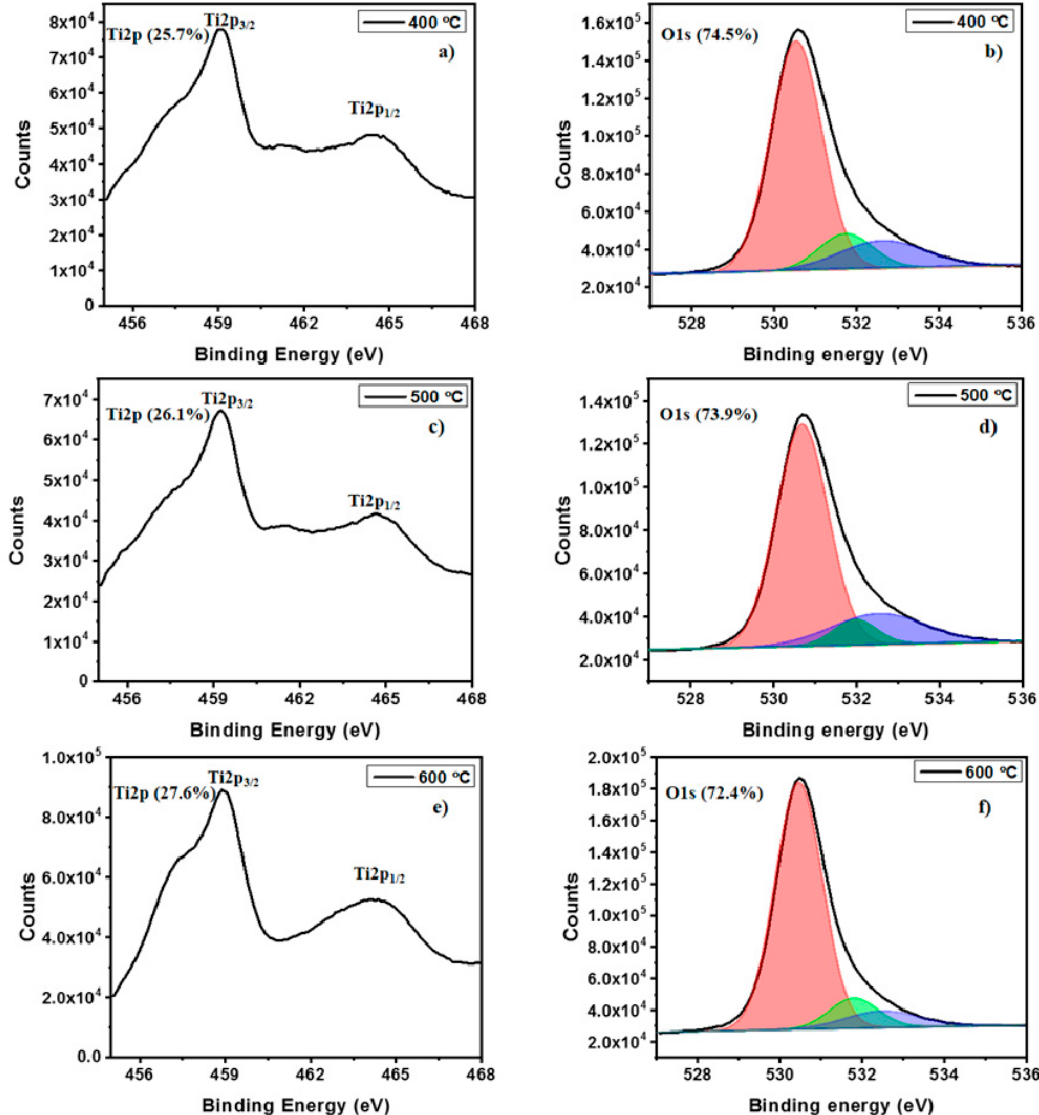
Figure 4. Deconvoluted XPS spectra of TiO 2 thin ‐ films post ‐ annealed at different temperature.